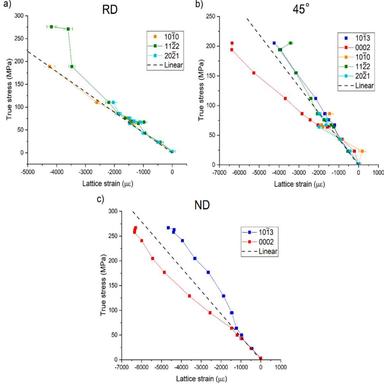
Evolution of the lattice strains with applied stress and their comparison with the linear behavior predicted by Hooke's law for the a) RD, b) 45° and c) ND samples.